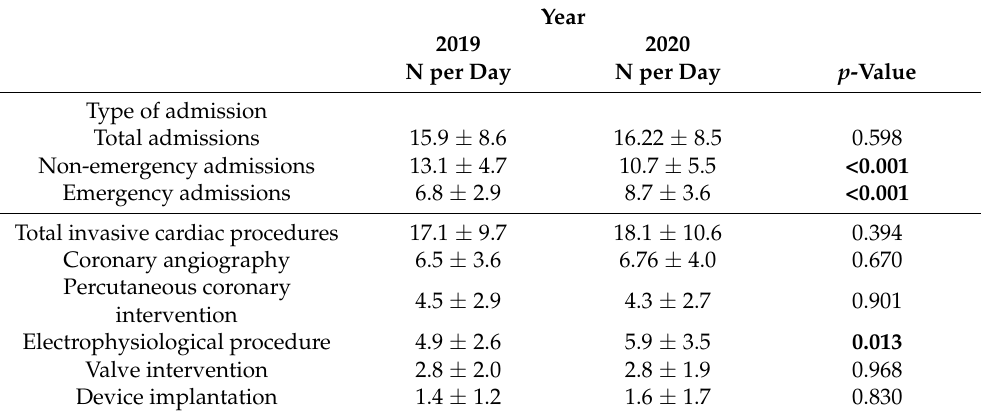
Table 1. Comparison of the number of hospital admissions and invasive cardiac procedures per day